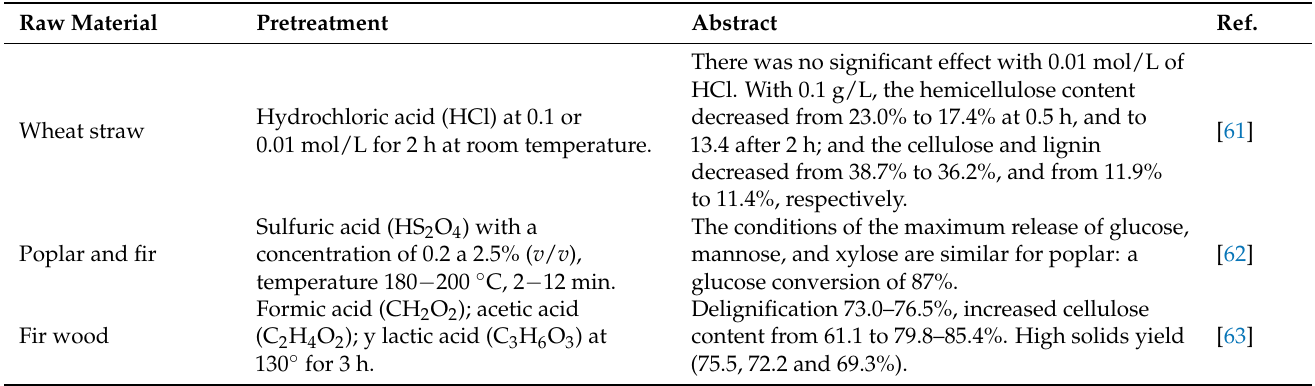
Table 2. Acid pretreatments applied on different types of